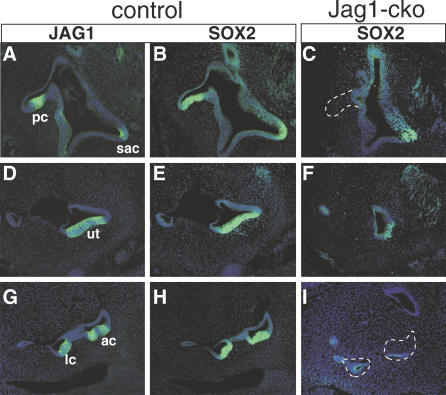
JAG1 and SOX2 Mark the Prosensory Regions of the Vestibule, and SOX2 Expression Correlates with Impaired Sensory Formation in the Jag1-cko Vestibule(A and B, D and E, G and H) Alternate sections demonstrating either JAG1 or SOX2 expression in the vestibular regions of control inner ears.(C, F, I) Similar sections through the Jag1-cko inner ear demonstrating SOX2 expression. Dotted lines indicate regions where the cristae and ampullae are missing in the Jag1-cko inner ear. ac, anterior cristae; lc, lateral cristae; pc, posterior cristae; sac, saccular macula; ut, utricular macula.